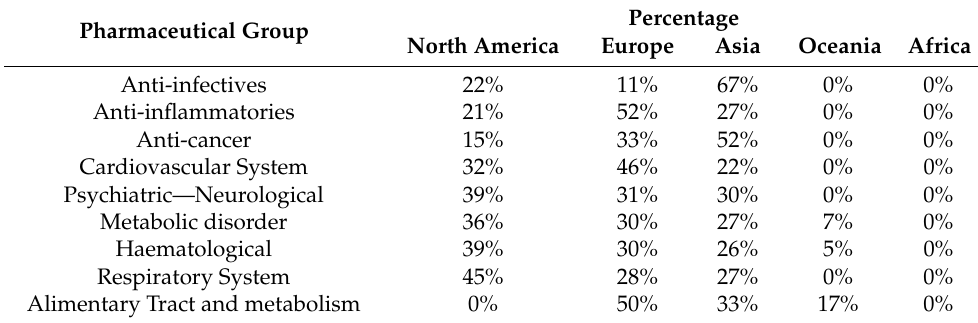
Table 3. Percentage distribution by geographical world regions of the research effort in terms of research articles for the removal of different pharmaceutical groups between 1998 to 2020 in Scopus using wastewater or water as keywords and English as a language limitation.